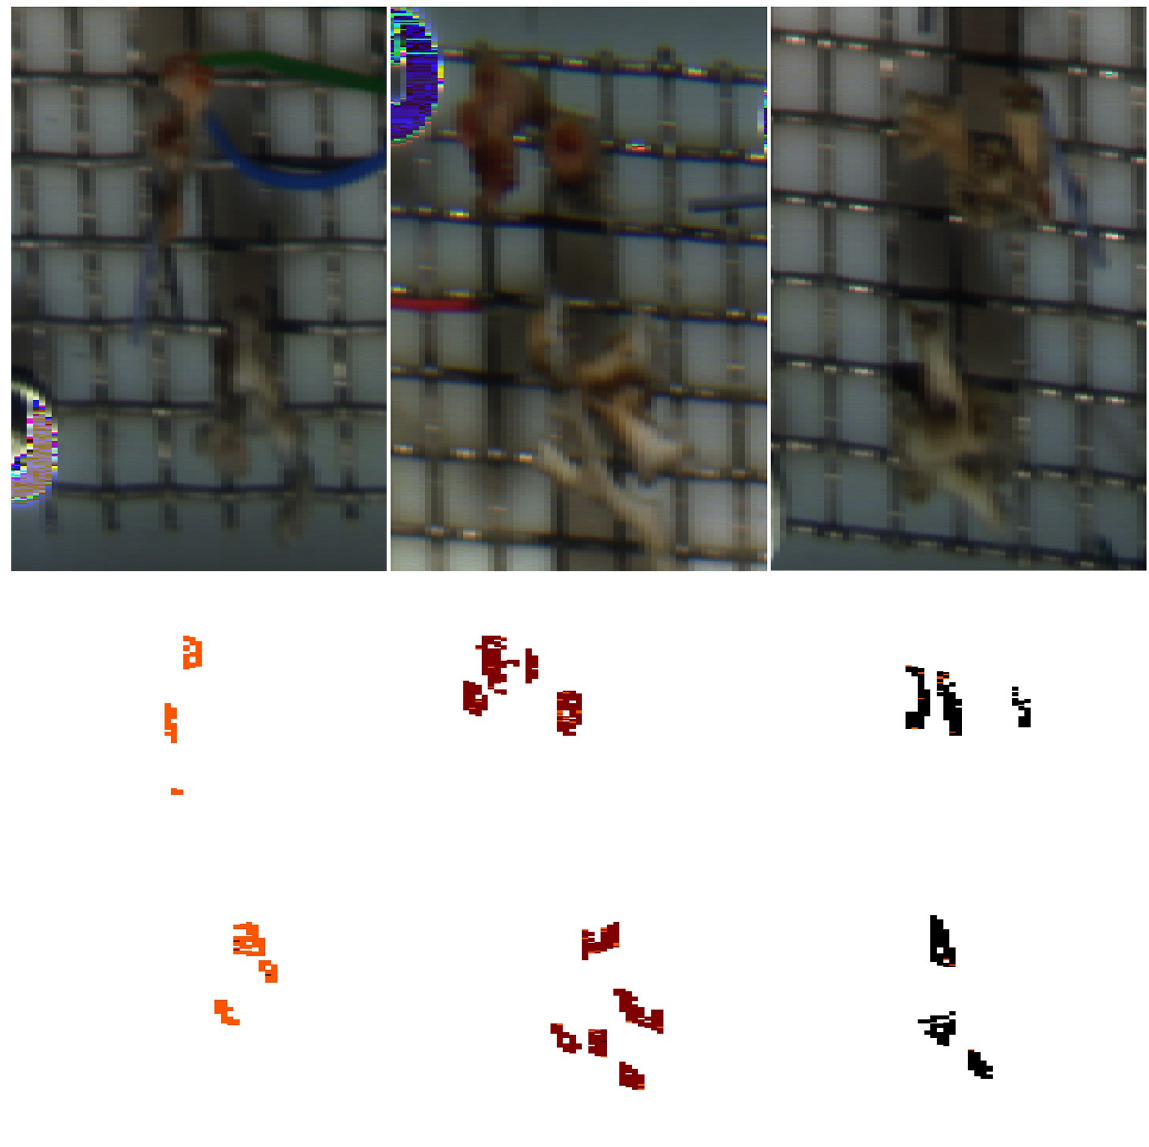
Fig 9. Classification of organisms. Two example corals from each exposure category: no- or low exposure (left), medium exposure (center), and high exposure (right). Note that the oddly colored patches in the lower left corner (left image) and upper left corner (center image) are caused by overexposure of a mechanical part holding the corals. The lower row shows classification into no- or low exposure (orange), medium exposure (red), and high exposure